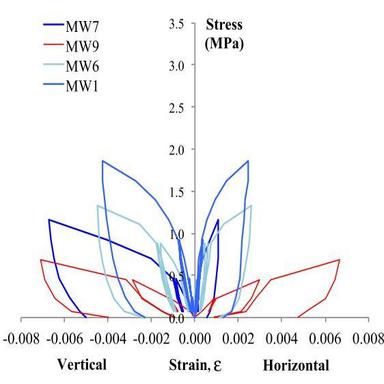
Strain/stress curves of the double flat-jacks tests.